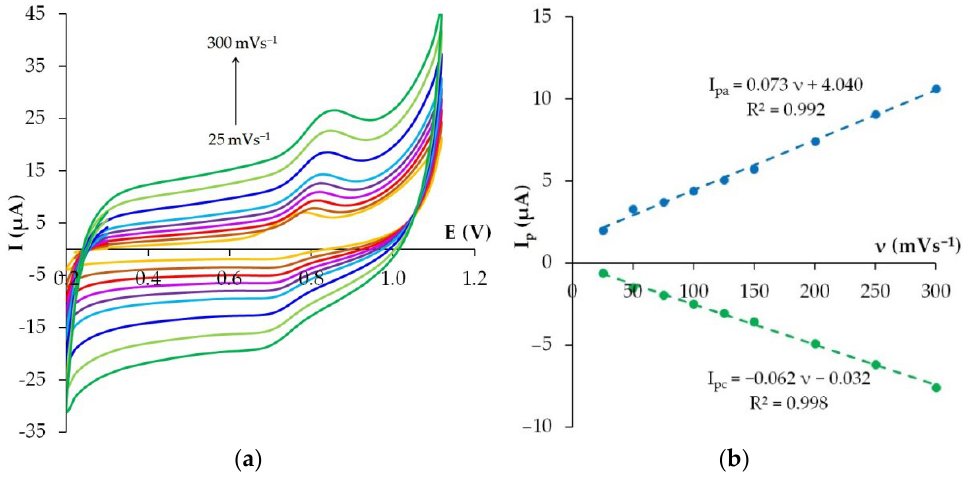
Figure 9. Linear sweep voltammograms of 5 μM Ponceau 4R on phyto-AuNPs/PDDA-G/CP electrode in phosphate buffer solution pH 5 at different potential scan rates: 25, 50, 75, 100, 125, 150, 200, 250, 300 mV s − 1 ( a ). I p vs. ν ( b ).